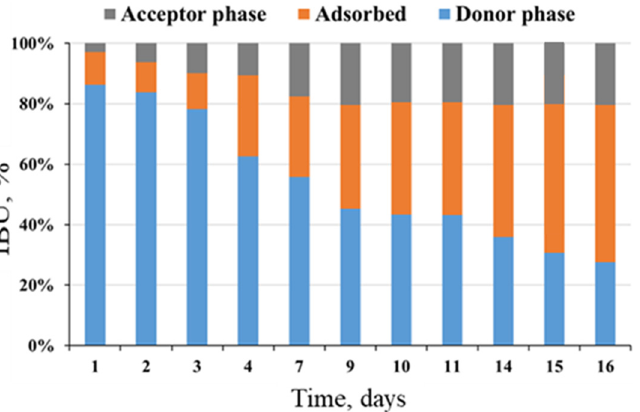
Figure 12. Percentage of IBU in donor (in blue) and acceptor (in grey) phases and the percentage of IBU adsorbed on the ALD-modified PDMS membrane (in orange) during the pertraction test.